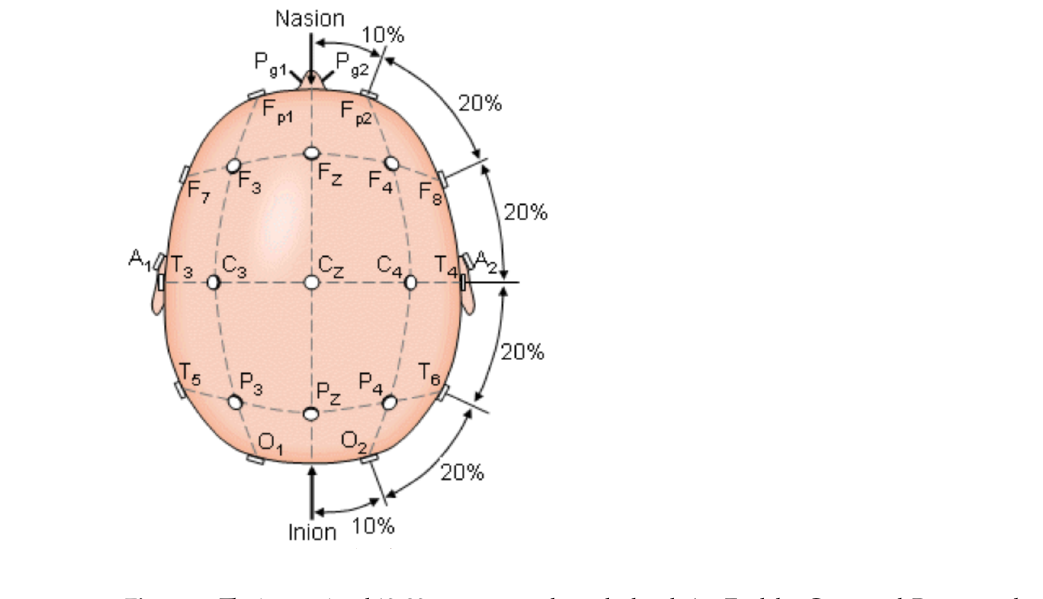
Figure 1. The international 10–20 system seen above the head. A = Ear lobe, C = central, Pg = nasopharyngeal, P = parietal, F = frontal, Fp = frontal polar, O = occipital